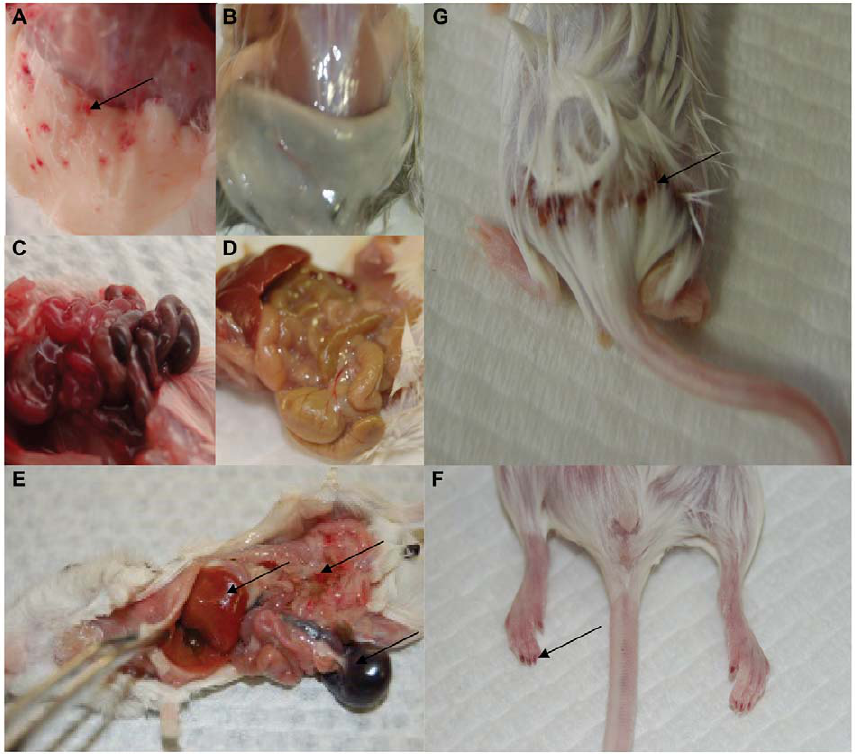
Figure 2. Overt signs of tissue morbidity and hemorrhage in the LCMV infected FVB mouse. Images were taken of FVB mice 6 to 8 days post-infection with LCMV -13. A) and B) Subcutaneous tissue in infected and uninfected FVB mice, respectively. C) and D) Gastro intestinal track of infected and normal FVB mice, respectively. E) General sites of blood pooling in the liver, stomach and GI track. F) and G) Cutaneous bleeding in the hindquarters and pooling of blood in the extremities, respectively. Arrows indicate sites of petechie and tissue